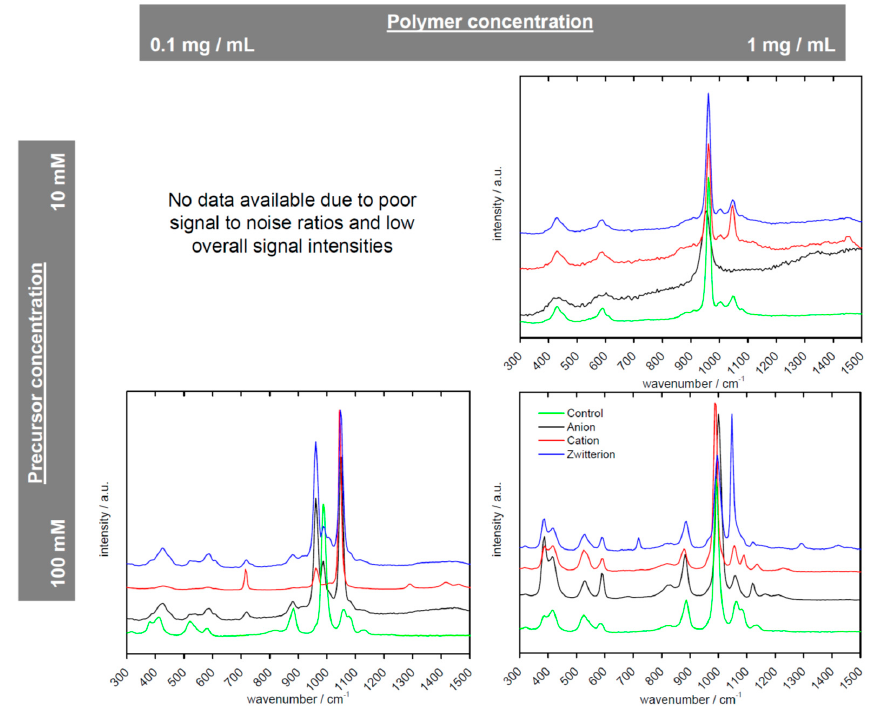
Figure 4. Representative Raman spectra of all samples investigated in this study.